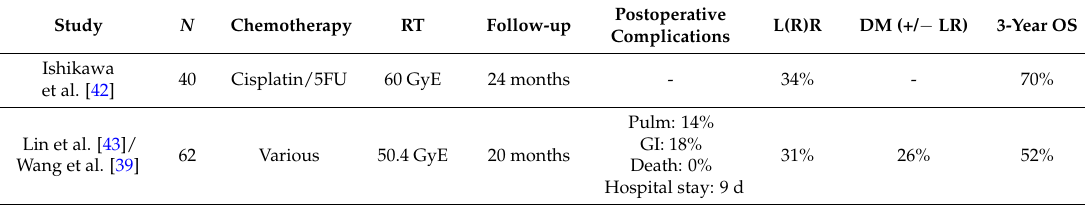
Table 4. Selected retrospective studies examining concurrent proton beam therapy and